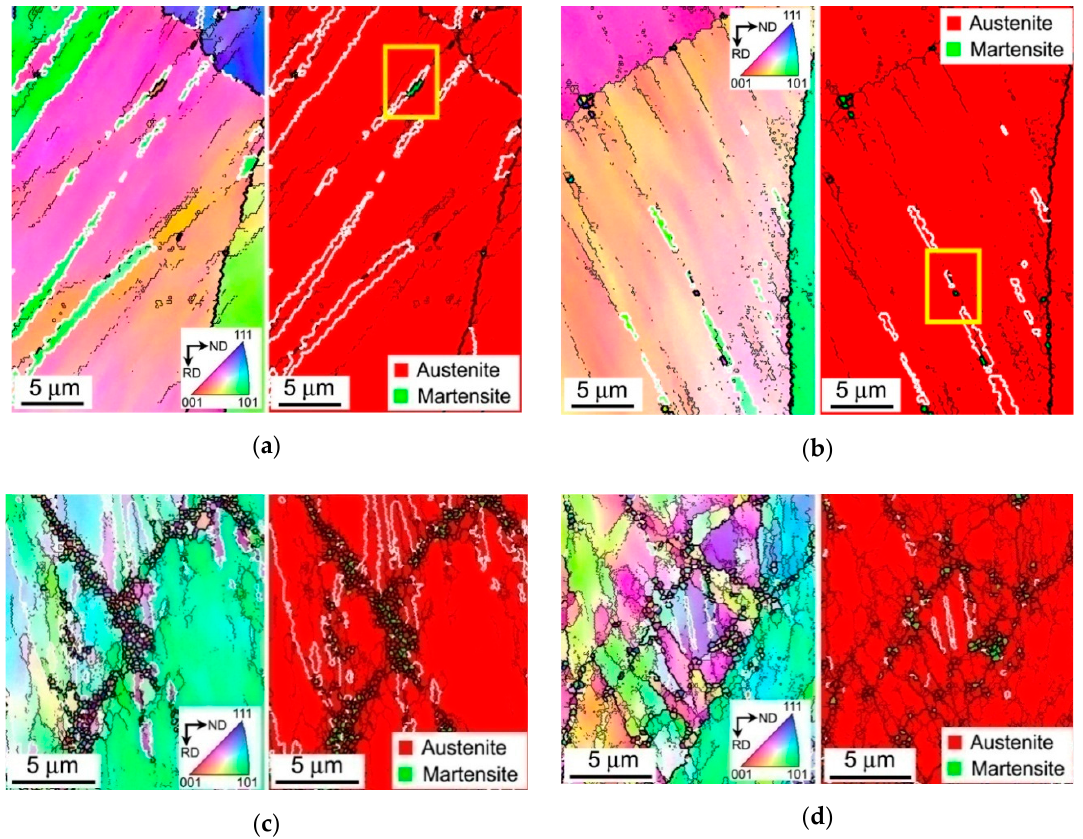
Figure 5. Strain-induced boundaries, twins and martensite in 304L ( a , c ) and 316L ( b , d ) stainless steels after rolling at 473 K to total strains of 0.5 ( a , b ) and 1 ( c , d ). High-angle, low-angle and twin boundaries are indicated by thick black, thin black and white lines, respectively.